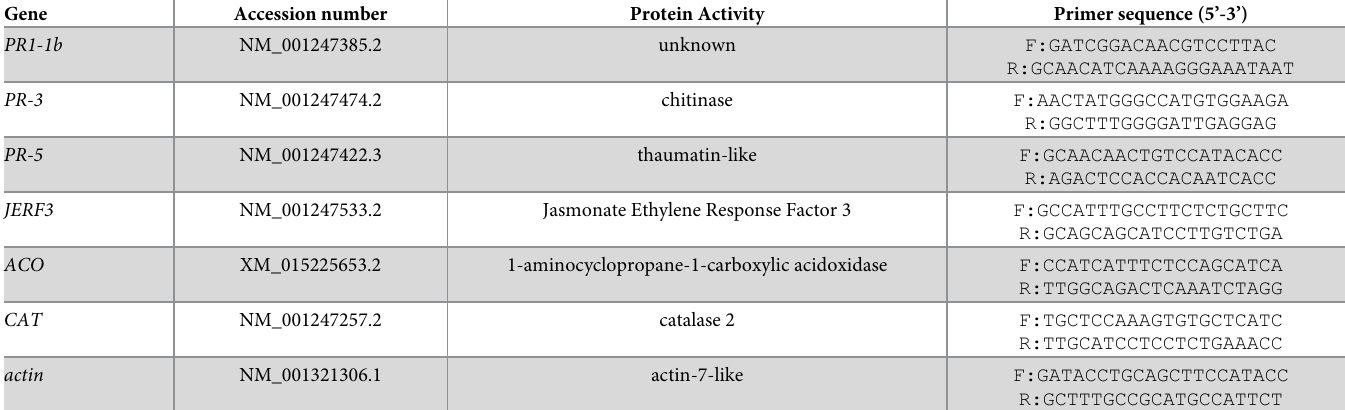
Table 1. Tomato defense-related genes examined in this study and the specific primers used in quantitative reverse transcriptase-polymerase chain reaction (qRT-PCR). Gene